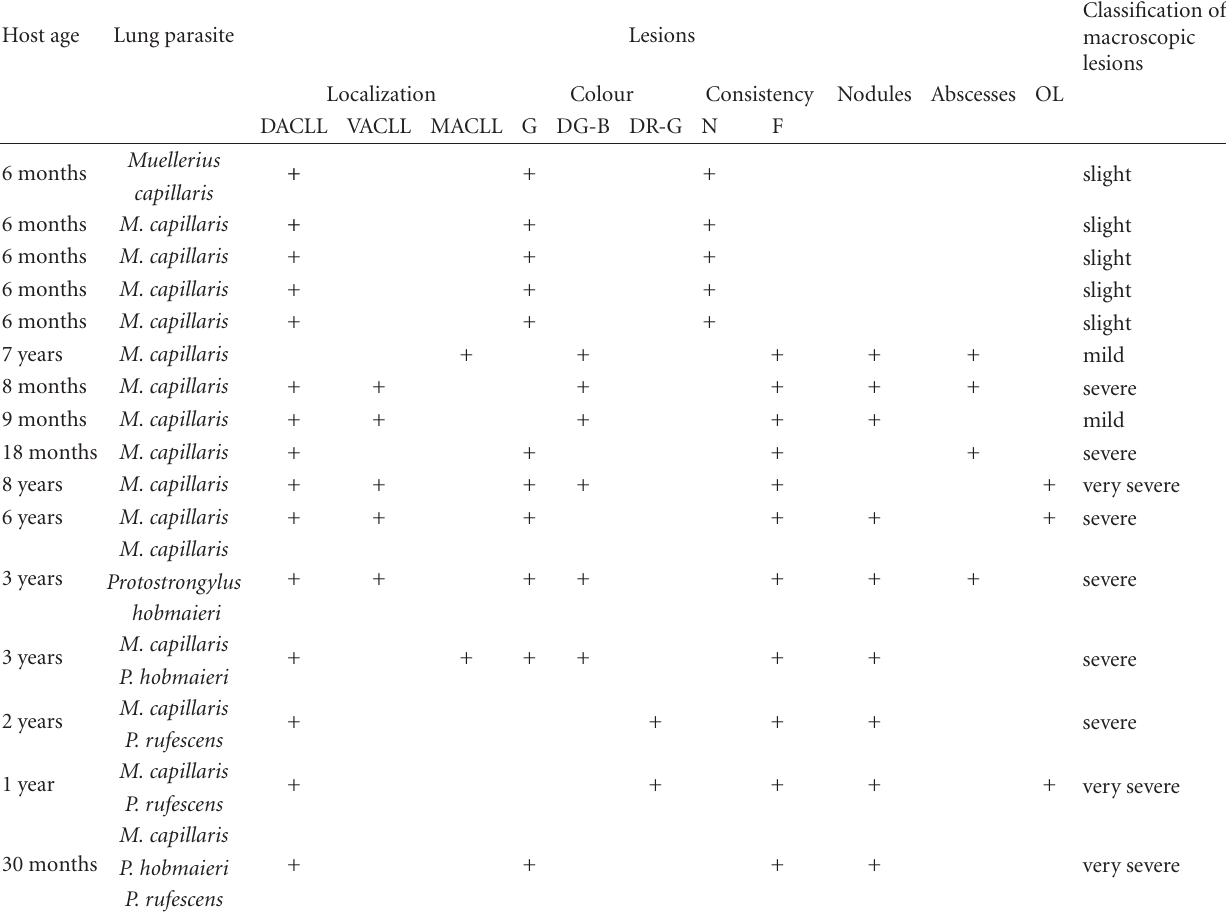
Table 1: Macroscopic lesions and classification of the lung change severity in goats with natural protostrongylid